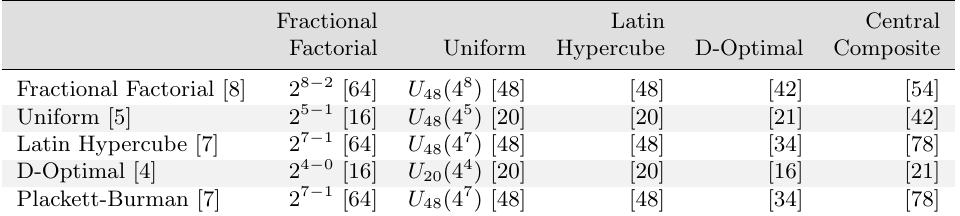
Table of designs used in the second phase experiments. Column names are phase 1 designs, and row names are phase 2 designs. In the row names the number in brackets denotes the number of significant variables, and in the table the number in brackets denotes the number of experiments